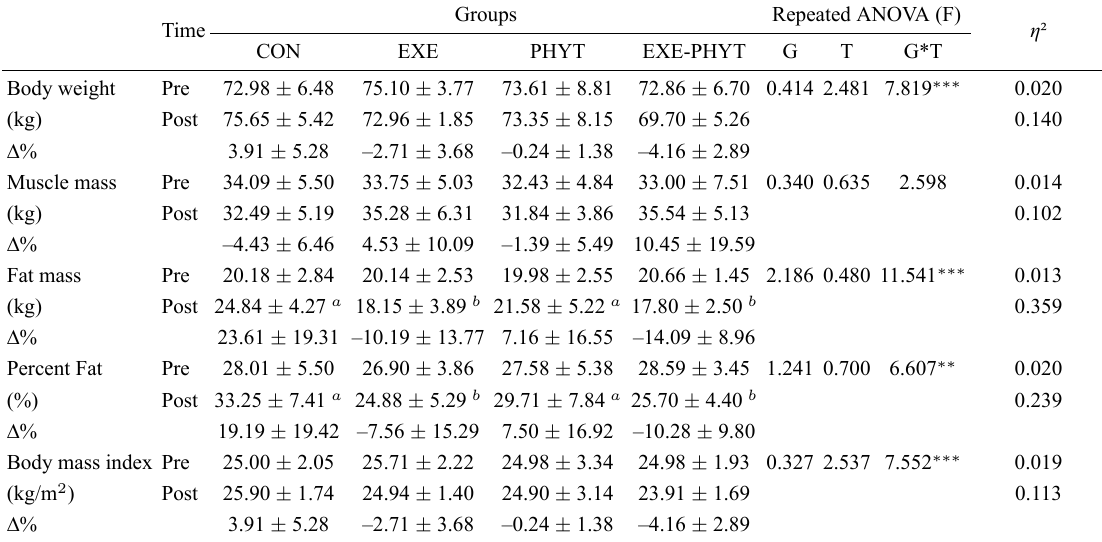
Table 7. Differences and changes of body